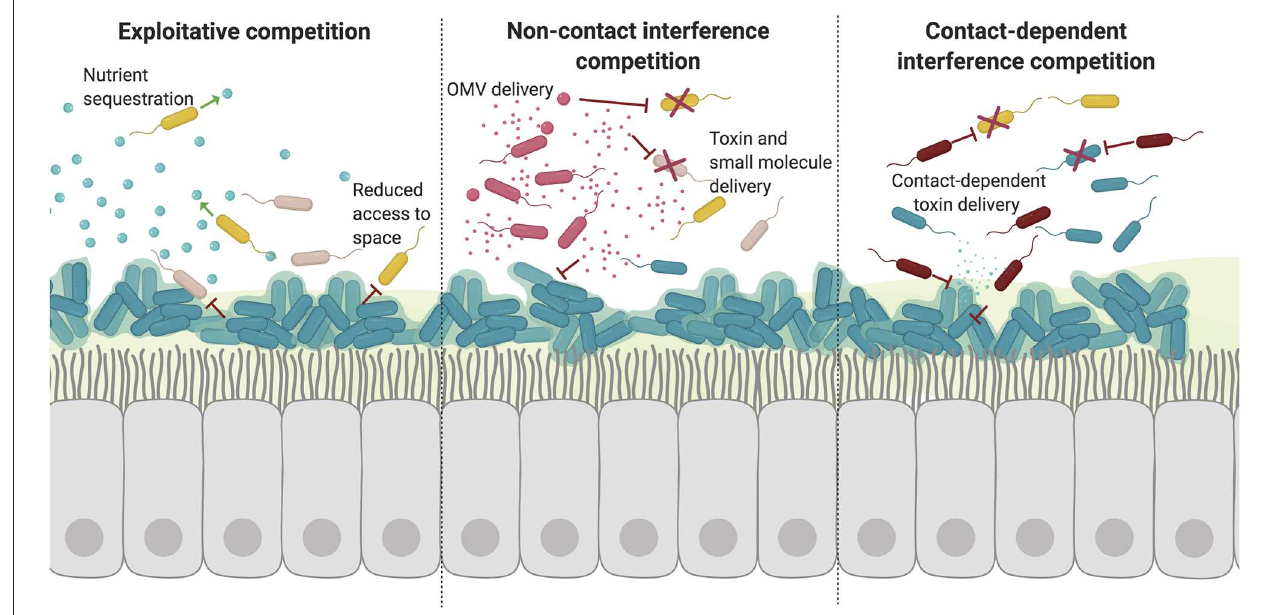
FIGURE 2 | Competitive interactions disrupt microbial communities. Competitive bacterial interactions can be exploitative or interfering, which is often energetically expensive and tightly regulated. (1) Exploitative competition takes advantage of extracellular nutrients and compounds released by other species. Such competition is often for trace metals which are actively sequestered but essential for bacterial growth. Other essential resources also include access to space. Formation of recalcitrant biofilms on epithelial surfaces restricts the colonization and growth of other species. (2) Bacteria can also interfere with other species growth and signaling through the active secretion and transport of toxic molecules. There are a variety of processes used to deliver toxic molecules over a distance including direct release into the extracellular environment and packaging into vesicles. (3) Finally, specific competition with neighboring bacteria can also occur via direct contact. In this way, bacteria can specifically deliver toxins directly to other cells in close proximity through mechanisms including contact-dependent inhibition and type VI